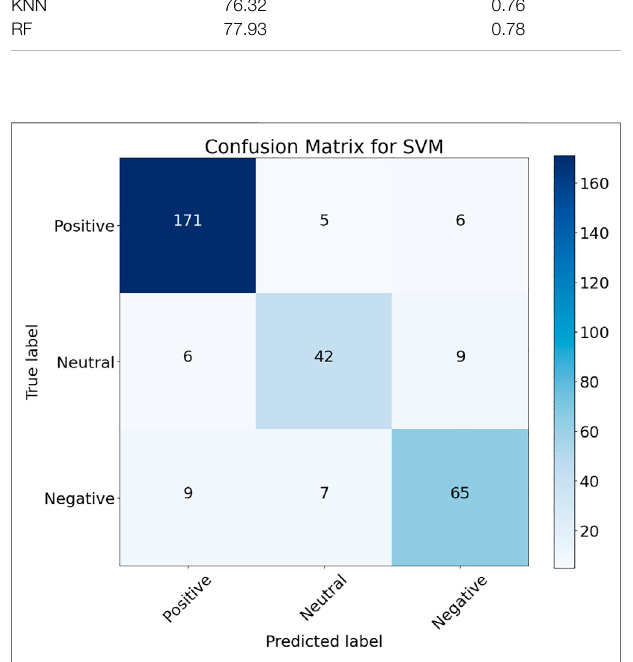
FIGURE 5 | SVM performance on test data set